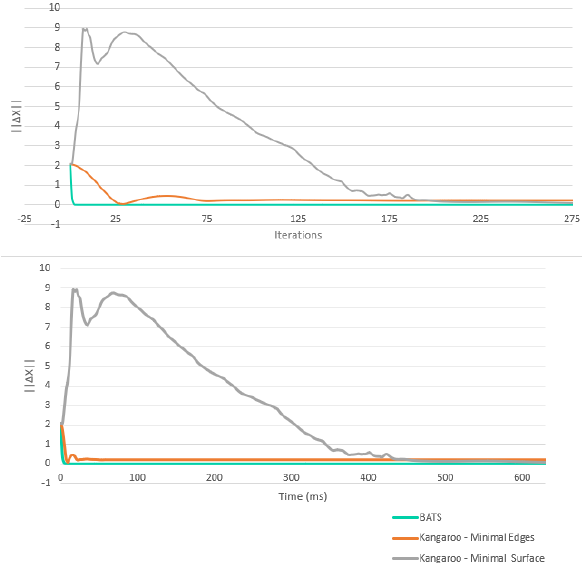
Figure 13: Iteration and time comparison for 25x25 grid